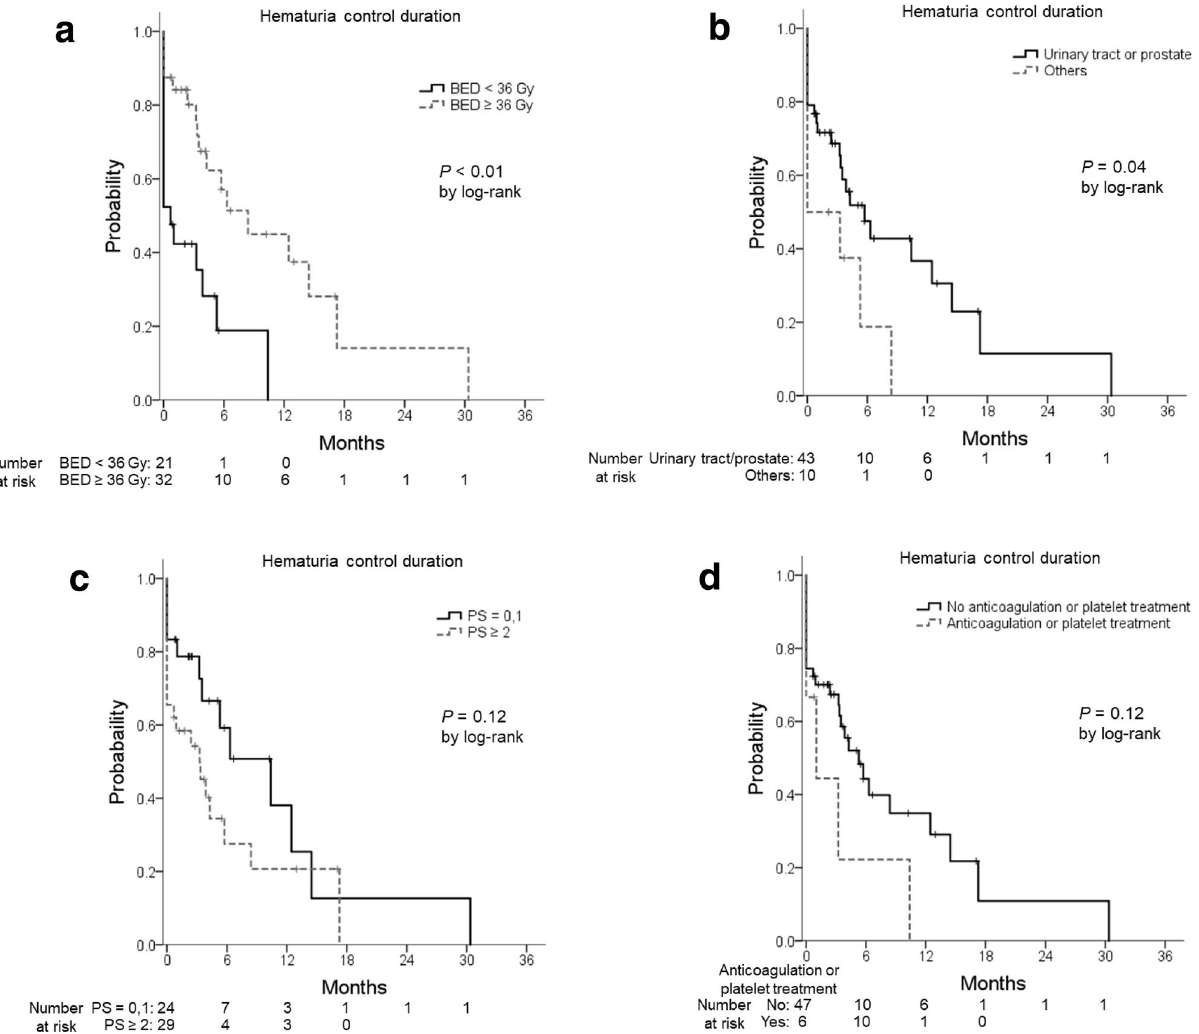
Figure 2. Hematuria control duration ( a ) by the biologically effective dose 10 (< 36 Gy/≥ 36 Gy), ( b ) by the primary tumor (urinary tract or prostate/others), ( c ) by the performance status (0,1/≥ 2), and ( d ) by anticoagulation or platelet treatment. Abbreviations: BED biologically effective dose, PS performance status.